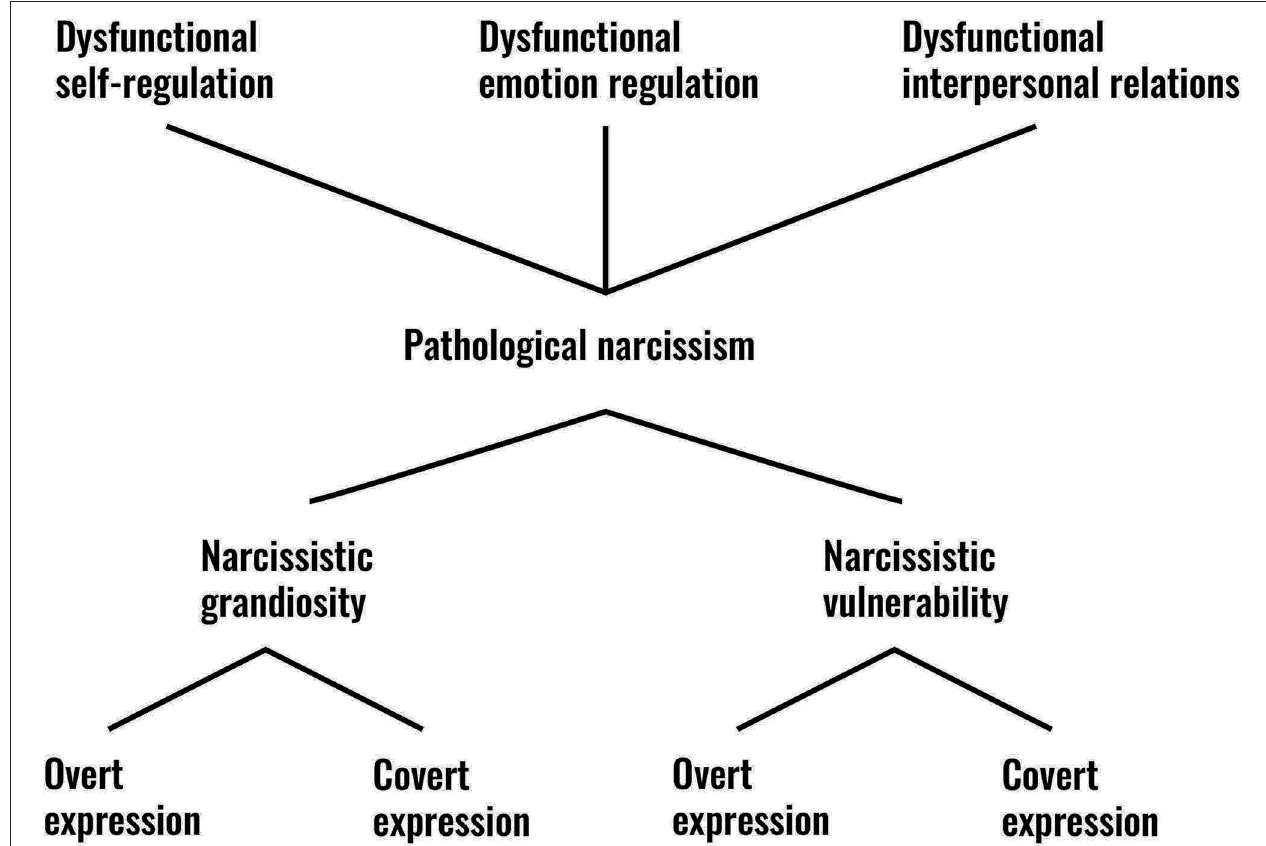
FIGURE 1 | Pincus and Lukowitsky’s model of